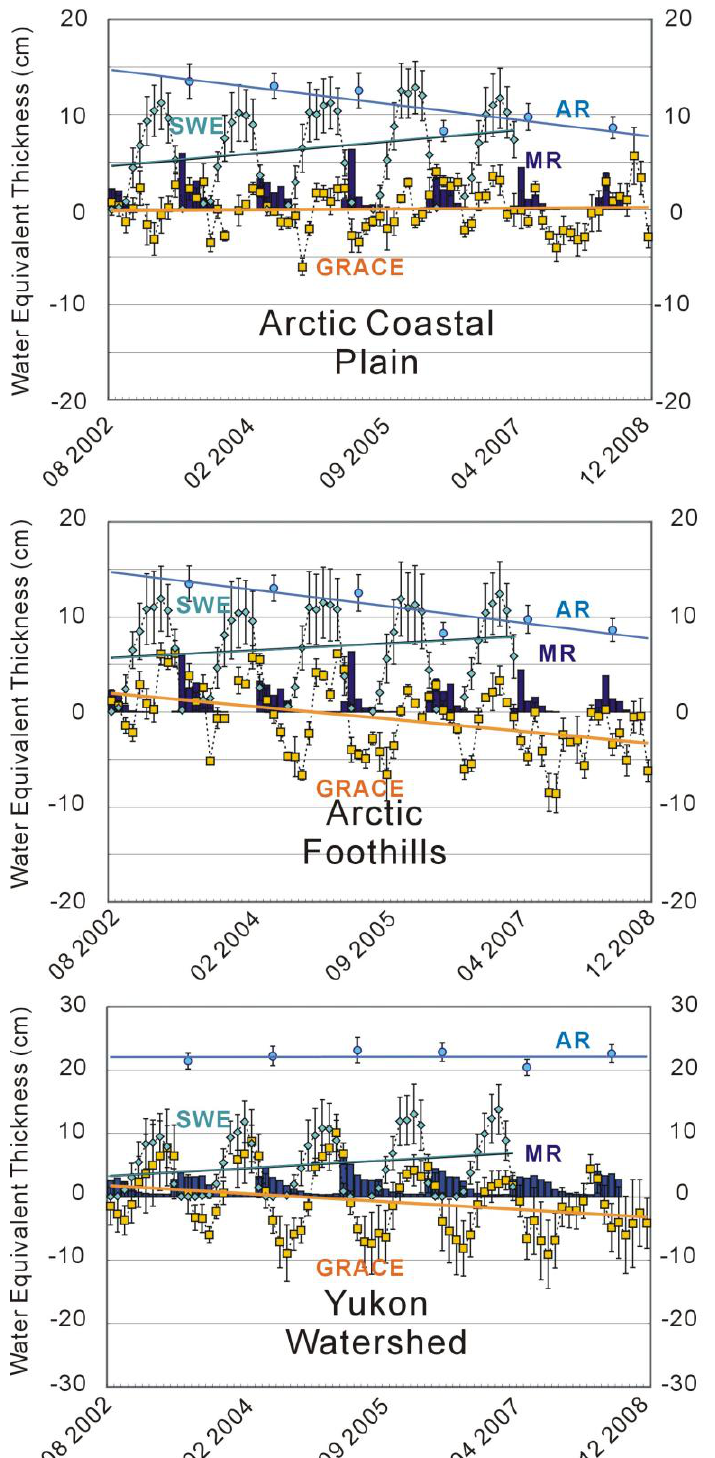
Figure 3. Regionalized time series of water mass changes and trends. Symbols refer to GRACE (orange filled squares), SSM/I SWE (light blue filled diamonds) and monthly runoff MR (blue bars) with annual runoff (August through July, light blue filled circles). T-bars denote regionalized standard